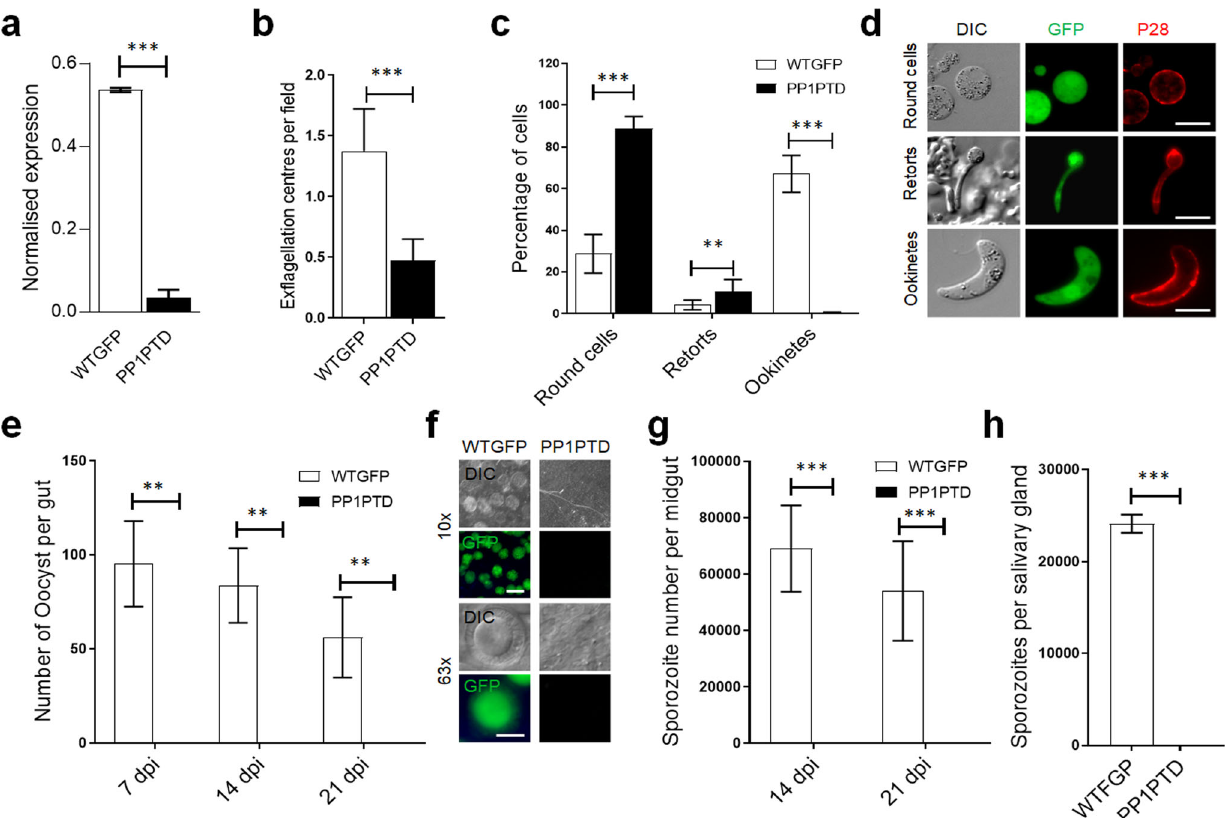
Fig. 4 PP1 has an important role during male gamete formation and zygote-ookinete development. a qRT-PCR analysis of pp1 transcription in PP1PTD and WT-GFP parasites, showing the downregulation of pp1 . Each bar is the mean of three biological replicates ±SD. b Male gametogony (ex fl agellation) of PP1PTD line (black bar) and WT-GFP line (white bar) measured as the number of ex fl agellation centres per fi eld. Mean ± SD; n = 3 independent experiments. c Ookinete conversion as a percentage for PP1PTD and WT-GFP parasites. Ookinetes were identi fi ed using P28 antibody as a surface marker and de fi ned as those cells that differentiated successfully into elongated ‘ banana shaped ’ ookinetes. Round cells show zygotes that did not start to transform and ‘ retorts ’ could not differentiate successfully in ookinetes. Mean± SD; n = 3 independent experiments. d Representative images of round cells, retorts and fully differentiated ookinetes. Scale bar = 5 μ m. e Total number of GFP-positive oocysts per infected mosquito in PP1PTD and WT-GFP parasites at 7-, 14- and 21-days post infection (dpi). Mean ± SD; n = 3 independent experiments. f Representative images of mosquito midguts on day 14 showing them full of oocysts in WTGFP and no oocyst in PP1PTD. Scale bar = 200 μ m for ×10 magni fi cation and 50 μ m for ×63 magni fi cation. g Total number of sporozoites in oocysts of PP1PTD and WT-GFP parasites at 14 and 21 dpi. Mean± SD; n = 3 independent experiments. h Total number of sporozoites in salivary glands of PP1PTD and WT-GFP parasites. Bar diagram shows mean ± SD; n = 3 independent experiments. Unpaired t -test was performed for statistical analysis. * p < 0.05, ** p < 0.01, *** p <